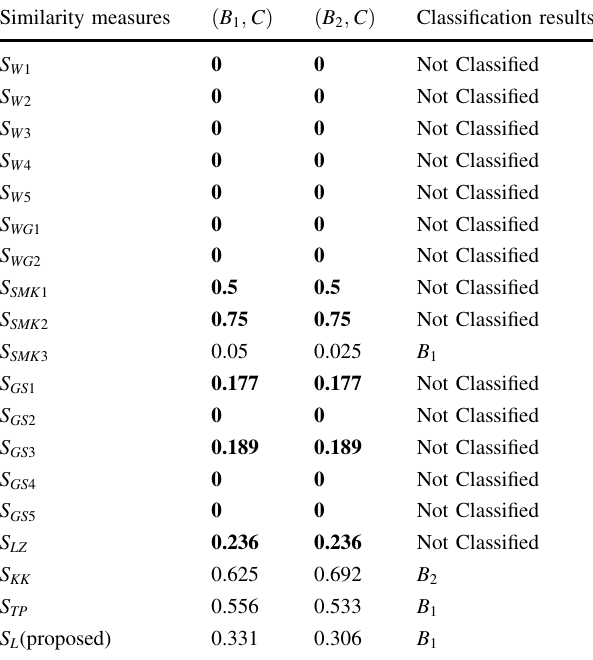
Table 4 The results of different similarity measures for pattern recognition Similarity